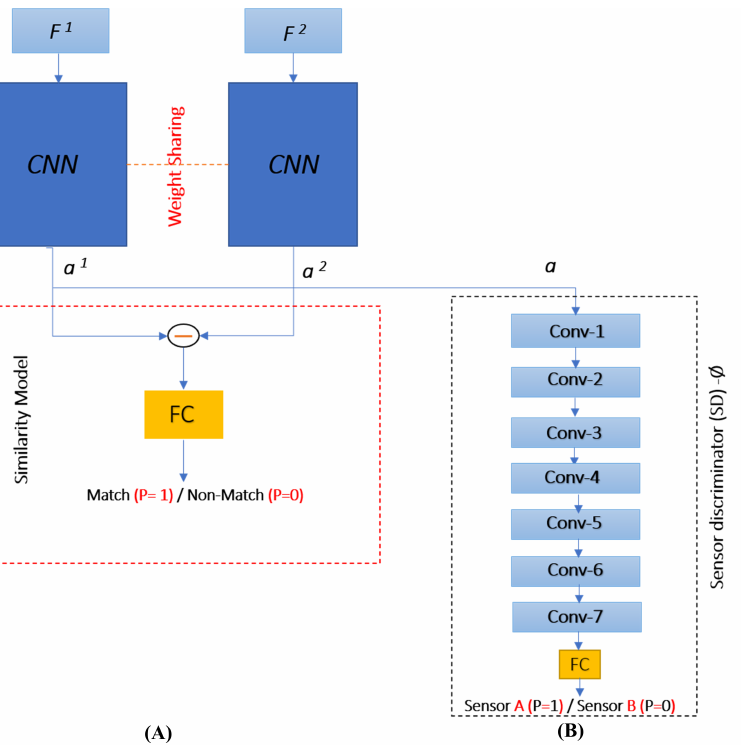
Figure 2. The design of the ( A ) Siamese network for matching (SiameseFinger) and ( B ) sensor discriminator (SD).